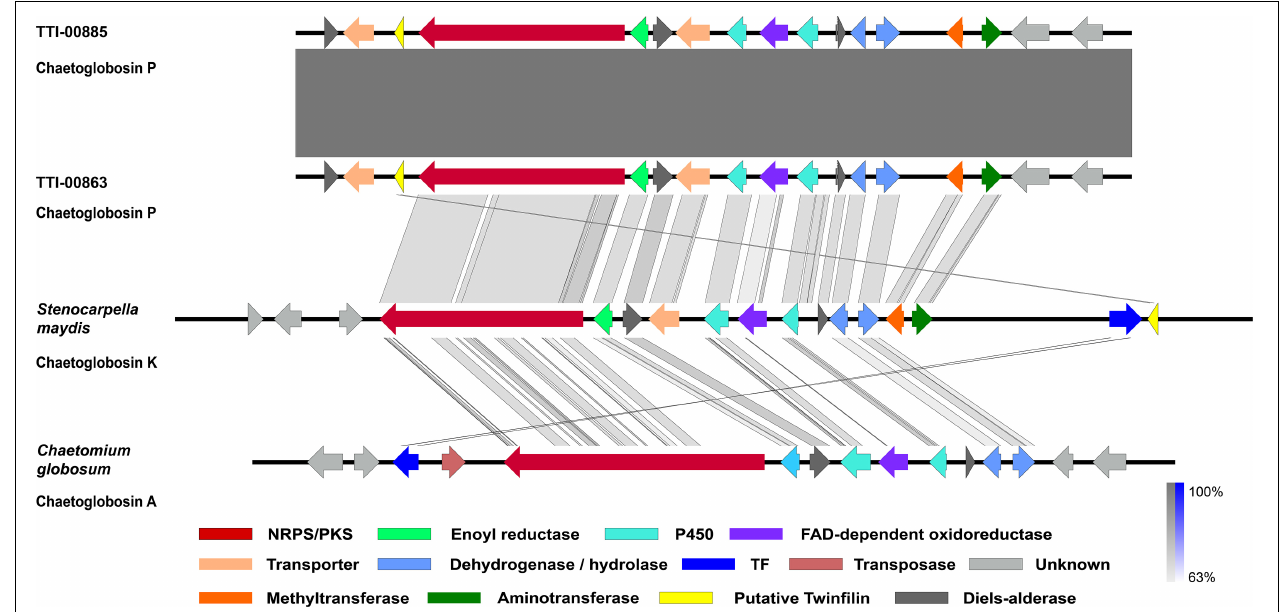
FIGURE 4 | Graphic representation of the putative and proven chaetoglobosin-type gene clusters and their microsynteny. Chaetoglobosin P gene cluster from Discosia rubi strains, the chaetoglobosin K gene cluster from Stenocarpella maydis A1-1, and the chaetoglobosin A gene cluster from Chaetomium globosum CBS 148.51. The intensity of the gray scale bar indicates the degree of nucleotide